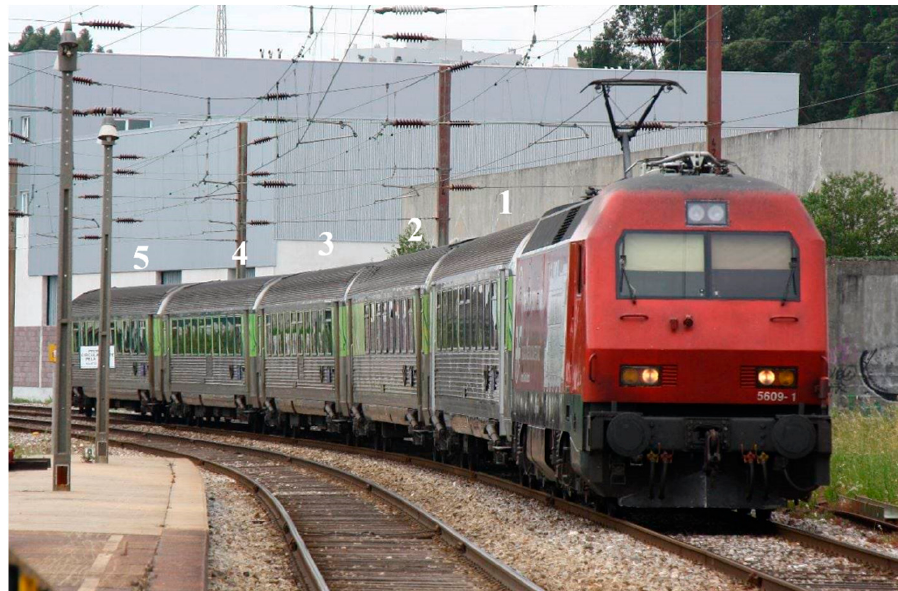
Figure 13. Intercity train in operation.